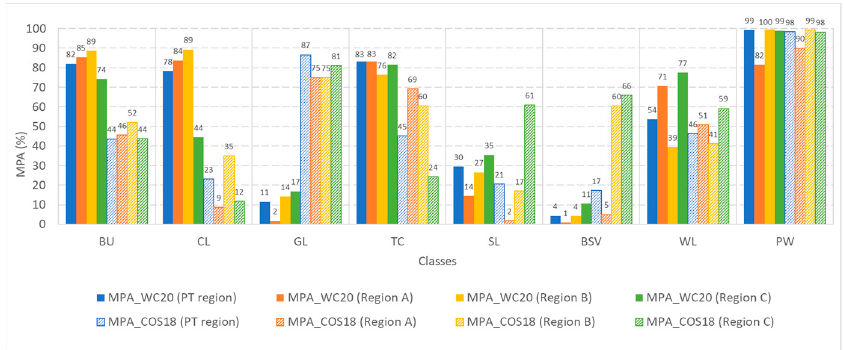
Figure 7. The MPA WC20 (solid fill) and the MPA COS18 (striped fill) for continental Portugal (PT) (blue color) and the three sub-regions A, B and C (represented, respectively, by the orange, yellow and green colors) plotted for each class.